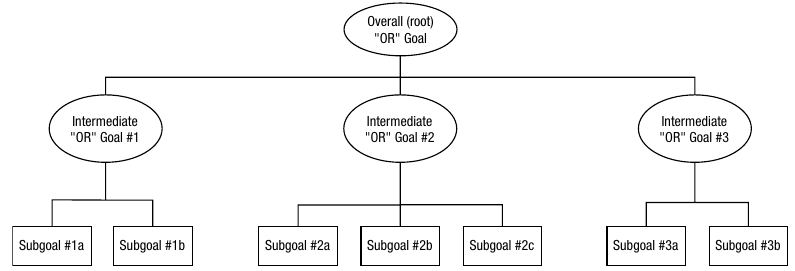
Fig. 4. General flowchart diagram of attack trees (Ingoldsby